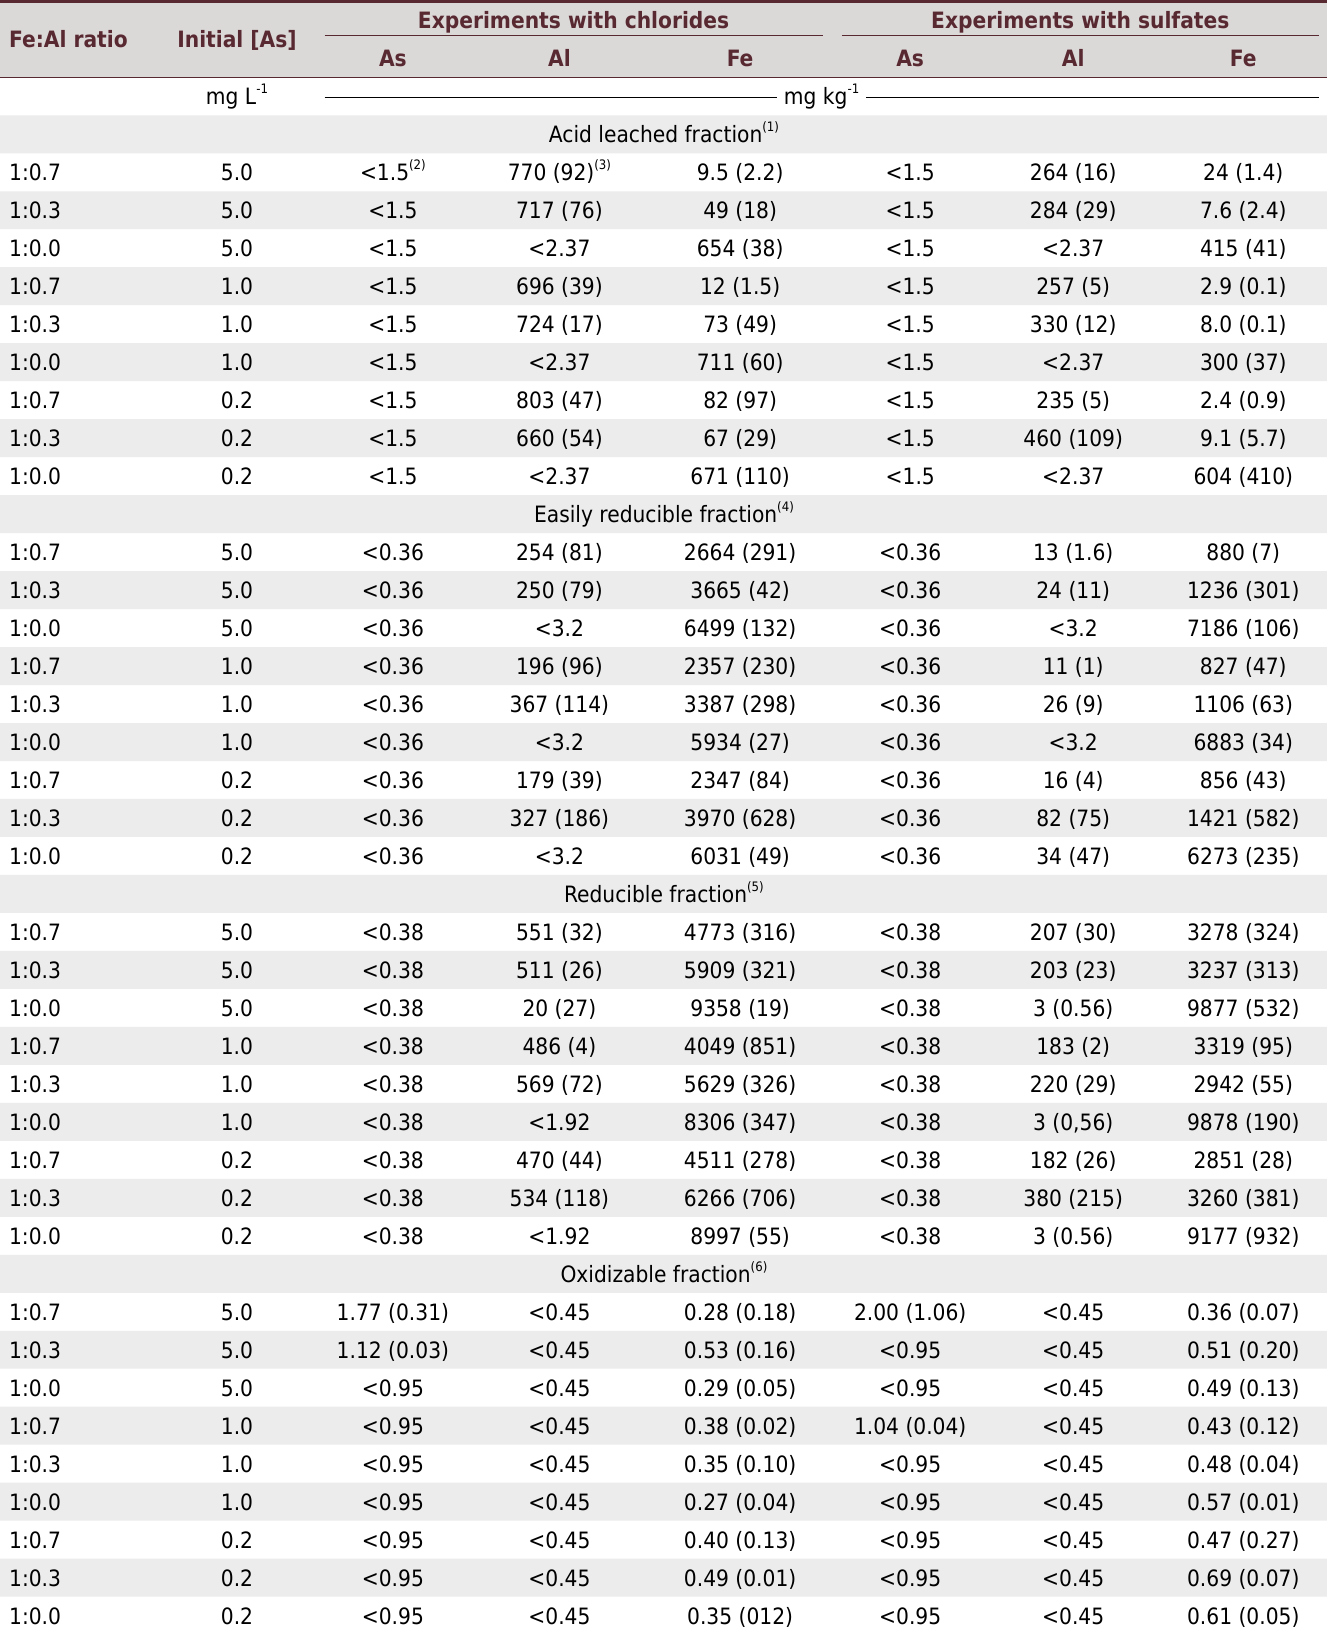
Table 7. Content of As, Al, and Fe in the precipitates leached using the BCR discrete extraction solutions, quantified by ICP-OES. Data calculated from values measured in the leachates and taking into account the precipitate/leachate ratio